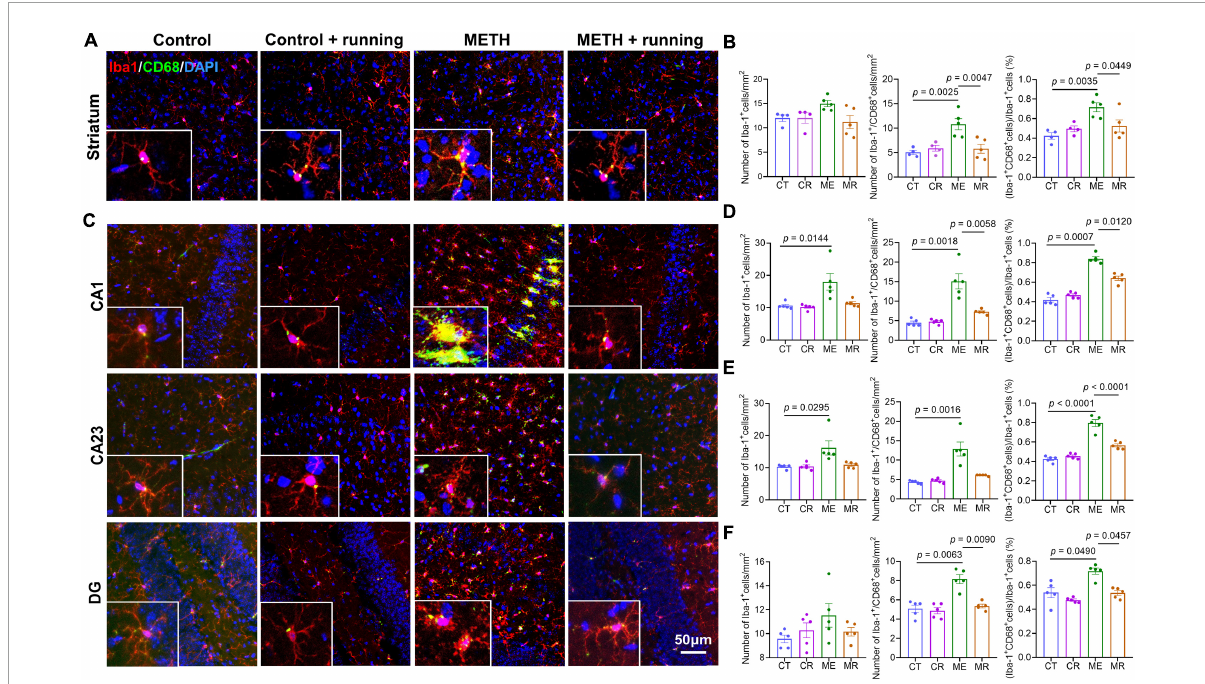
FIGURE4 Treadmill exercise decreased microglial activation in the striatum and subregions of hippocampus of mice with acute METH withdrawal. (A) Immunofluorescence staining of striatal sections from four groups of mice. The bottom left corner of each picture is the enlarged pictures for the CD68 and Iba-1. (B) The number of Iba-1 + cells (left), the number of Iba-1 + /CD68 + cells (middle), and the percentage of Iba-1 + /CD68 + microglia in Iba-1 + cells (right) from four groups ( n = 4–5 each group) in the mouse striatum. The data are expressed as the mean ± SEM, and p < 0.05 was considered a significant difference. (C) Immunofluorescence staining of hippocampal subregion (CA1, CA23, DG) sections from the four groups of mice. The bottom left corner of each picture is the enlarged pictures for the CD68 and Iba-1. (D–F) The number of Iba-1 + cells (left), the number of Iba-1 + /CD68 + cells (middle), and the percentage of Iba-1 + /CD68 + microglia in Iba-1 + cells (right) from four groups (n = 4-5 each group) in the mouse CA1 (D) , CA23 (E) , and DG (F) subregions. The data are expressed as the mean ± SEM, and p < 0.05